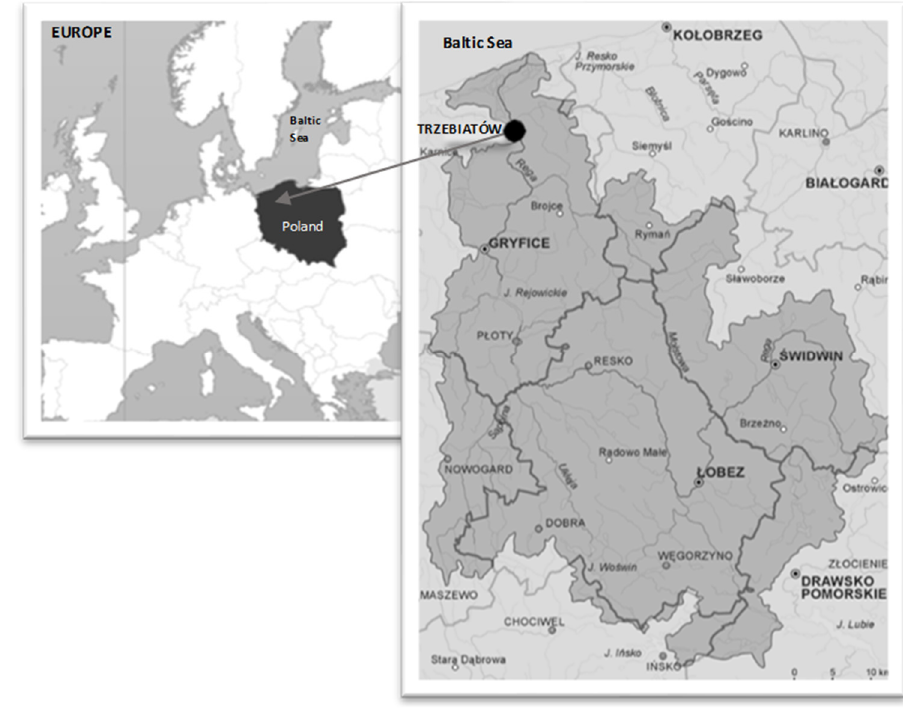
Figure 1. Location of the study area on the river Rega, north-western Poland.